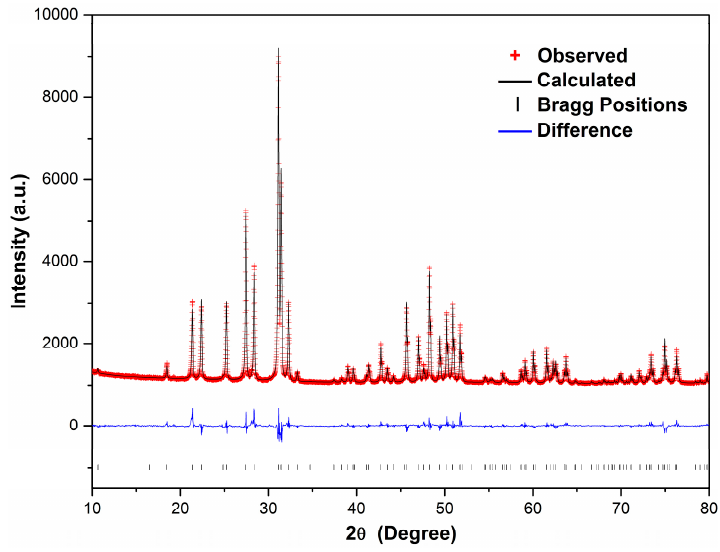
Figure 2. Fitted diffraction profiles of the as-grown PSO single crystal at room temperature. Table 1. Refined structural parameters for the as-grown PSO crystal according to P 6 3 /m model.